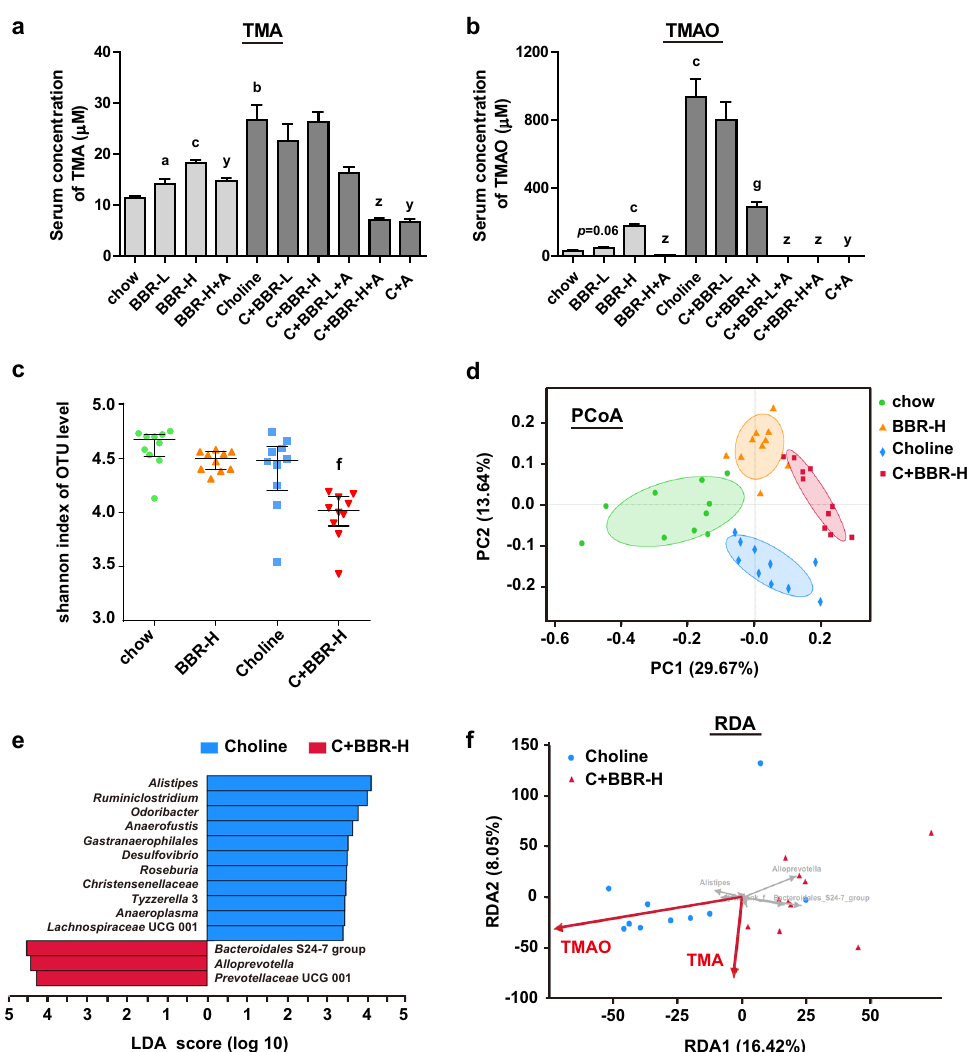
Fig. 1 BBR decreased TMAO level in choline diet-fed C57BL/6J mice. Eight-week-old female C57BL/6J mice were fed chow, chow with 100 mg/kg BBR (BBR-L) or 200 mg/kg BBR (BBR-H), chow with choline (1%), or chow with choline (1%) plus 100 mg/kg BBR (C + BBR-L) or 200 mg/kg BBR (C + BBR-H) in the absence or presence of Abs ( + A) for 6 weeks. a , b Serum TMA and TMAO levels were determined by HPLC/ MS. Values are presented as means ± SEM ( n = 10). a p < 0.05; b p < 0.01; c p < 0.001 (versus chow-diet group); g p < 0.001 (versus choline-diet grou p ); y p < 0.01; z p < 0.001 (versus relevant group without Abs). c Microbiota alpha diversity was measured by 16S rRNA gene sequence analysis of the cecal content samples ( n = 10 for each group) using Shannon index (based on OTU level). Error bars were median with interquartile ranges, and p values were from Kruskal – Wallis H test. f, p < 0.01 (versus choline-diet group). d Principal coordinate analysis (PCoA) of bray curtis distance was analyzed based on OTU level for microbiota beta diversity ( n = 10 for each group, ANOSIM R = 0.6383, p = 0.001). e Linear discriminant analysis (LDA) identi fi ed the taxa most differentially abundant between the choline and C + BBR-H group at the genus level. Only taxa meeting an LDA signi fi cant threshold value of ≥ 3.3 are shown. f Redundancy analysis (RDA) visualized the correlation between key phylotypes of gut microbiota within choline and C + BBR-H group (at the genus level, gray arrows) and TMA and TMAO level (red arrows; correlation coef fi cient r 2 = 0.3297, p = 0.042 and r 2 = 0.3838, p = 0.013